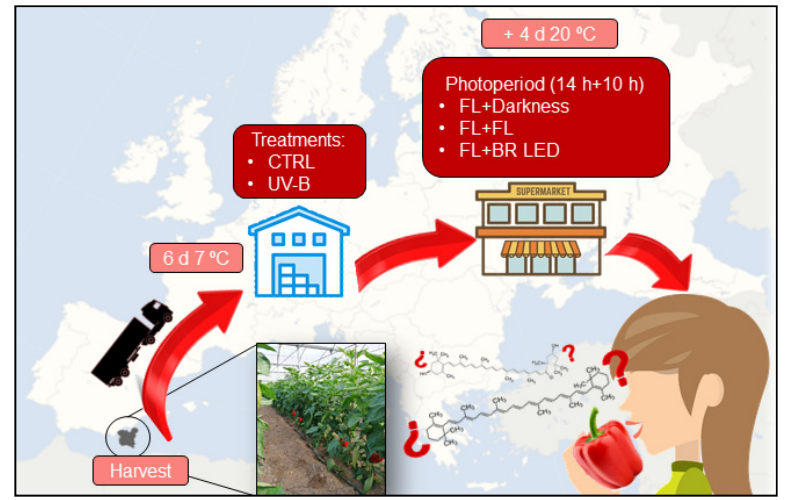
Figure 1. Schematic representation of the experimental design of the study.